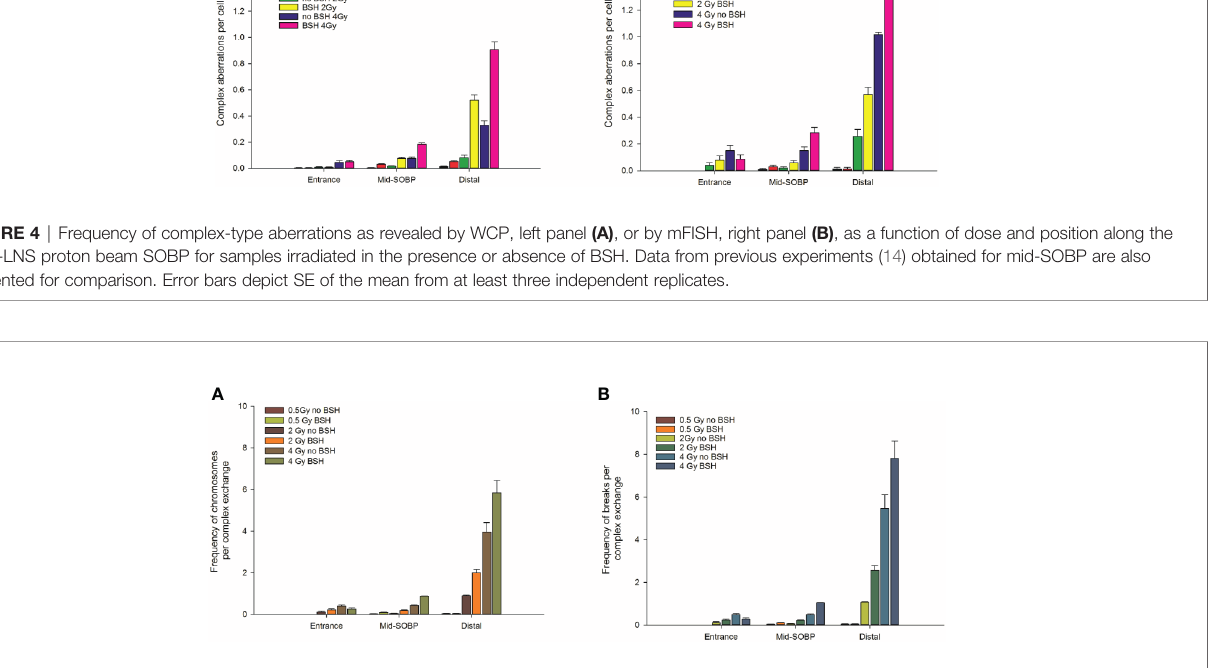
FIGURE 5 | Classi fi cation of complex exchanges revealed by mFISH analysis in terms of number of chromosomes involved in complex exchanges per cell, left panel (A) , and number of breaks in complex exchanges per cell, right panel (B) for MCF-10A cells irradiated at entrance, mid, and distal positions of the INFN-LNS low-energy clinical proton beam.